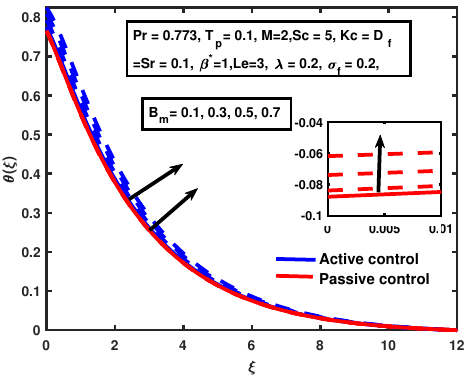
Figure 6. The impact of θ ( ξ ) on Brownian motion B m